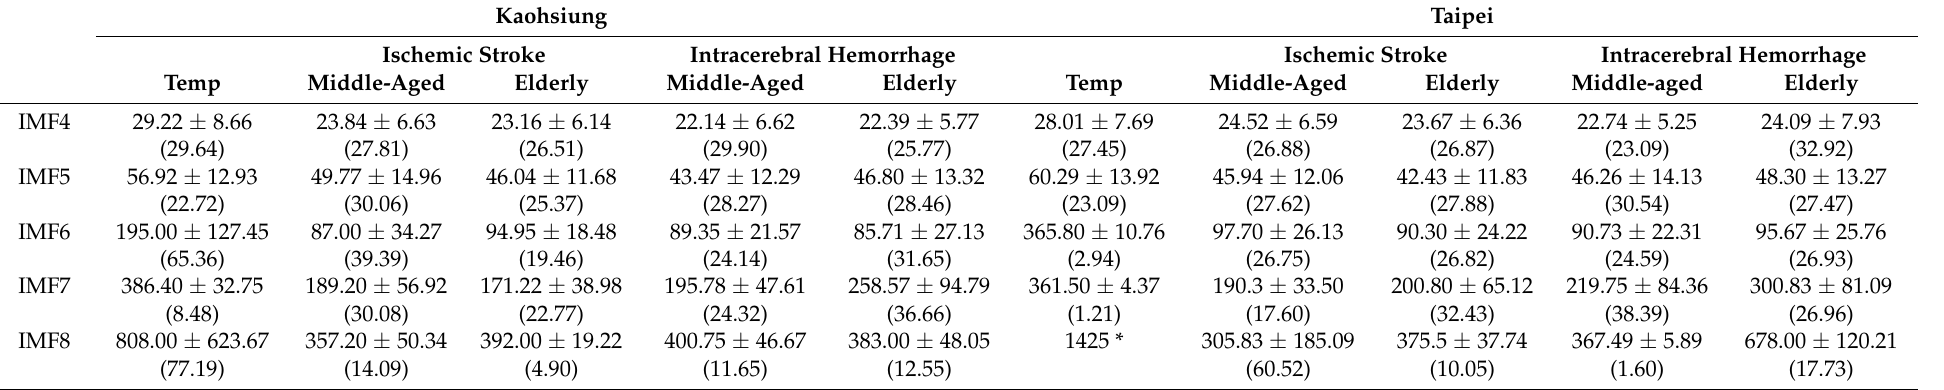
Table 3. Interpeak periods of decomposed daily ambient temperatures and stroke events in Kaohsiung City and the Taipei